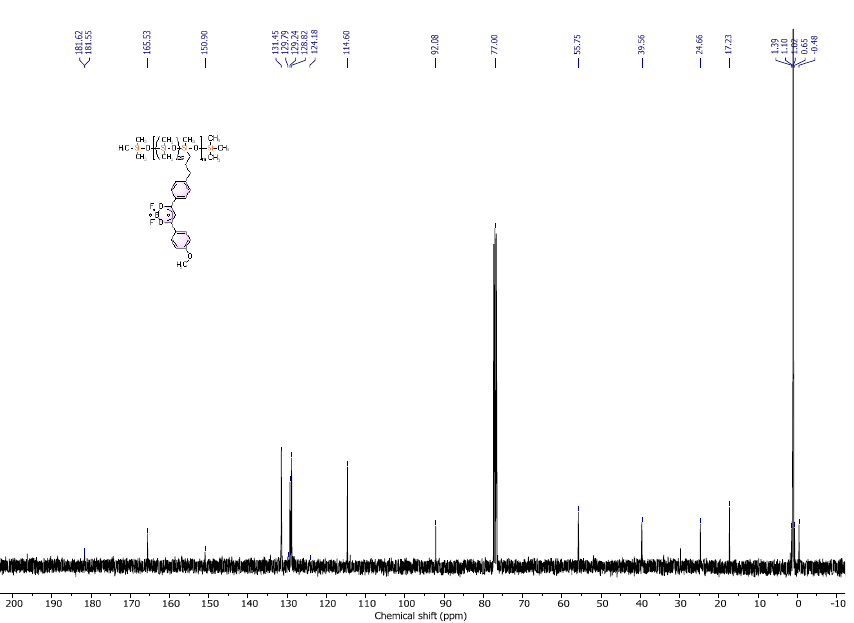
Figure 5. 13 C NMR spectrum of polymer 3 a in CDCl 3 .